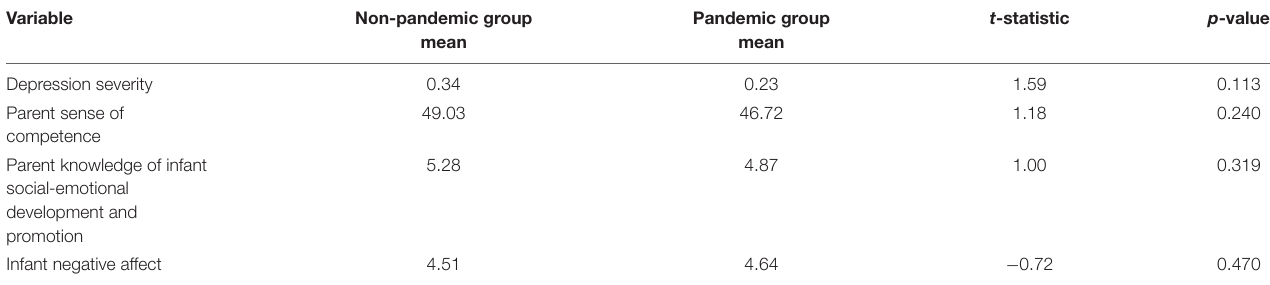
TABLE 2 | Intrapersonal risk characteristics by pandemic and non-pandemic